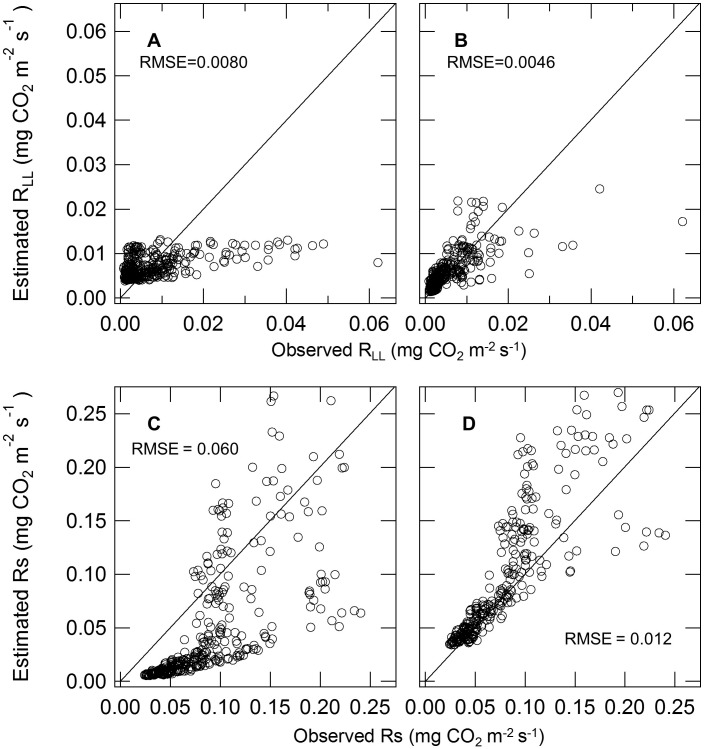
Relationship between observed and estimated CO2 efflux rate from leaf litter respiration (R
LL) and soil respiration (R
S).
R
LL (A, B) and Rs (C, D) show daily mean values. Estimated respiration rates were calculated using a function of temperature (A, C) from Eq. (5,6) and a function of temperature and water content (B, D) from Eq. (7,8) in the Results. Lines represent the 1∶1 ratio. RMSE: root mean square error.